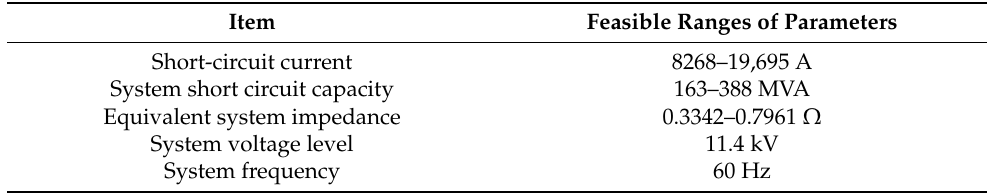
Table 3. Parameters of the test system.